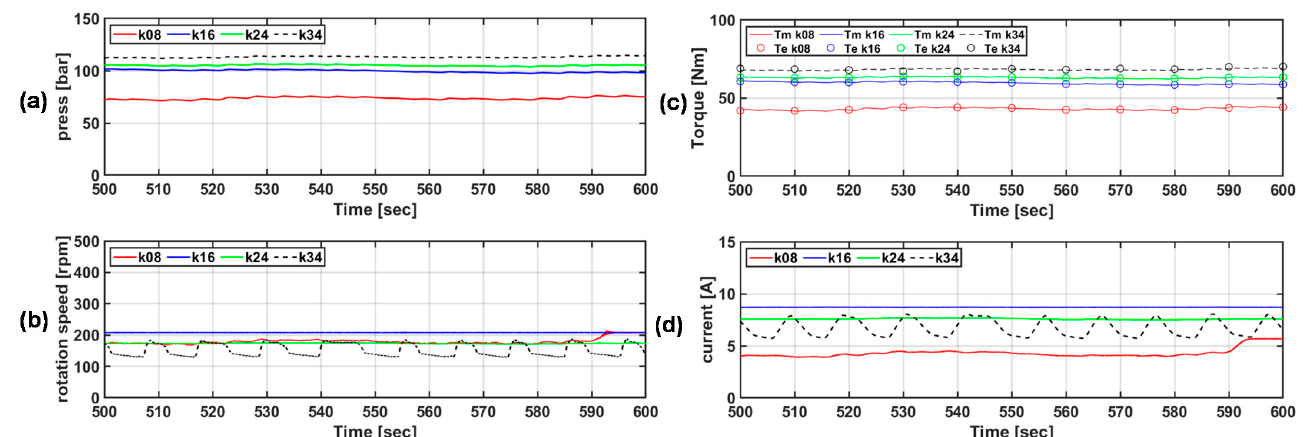
Figure 21. ( a ) Pressure in the circuit, ( b ) hydraulic motor rpm, ( c ) mechanical and electrical torque, and ( d ) electrical load current according to the torque coefficient of the optimal torque control algo- rithm under irregular wave conditions ( H s = 0.75 m, T p = 4.75 s) (legends indicate torque coeffi-